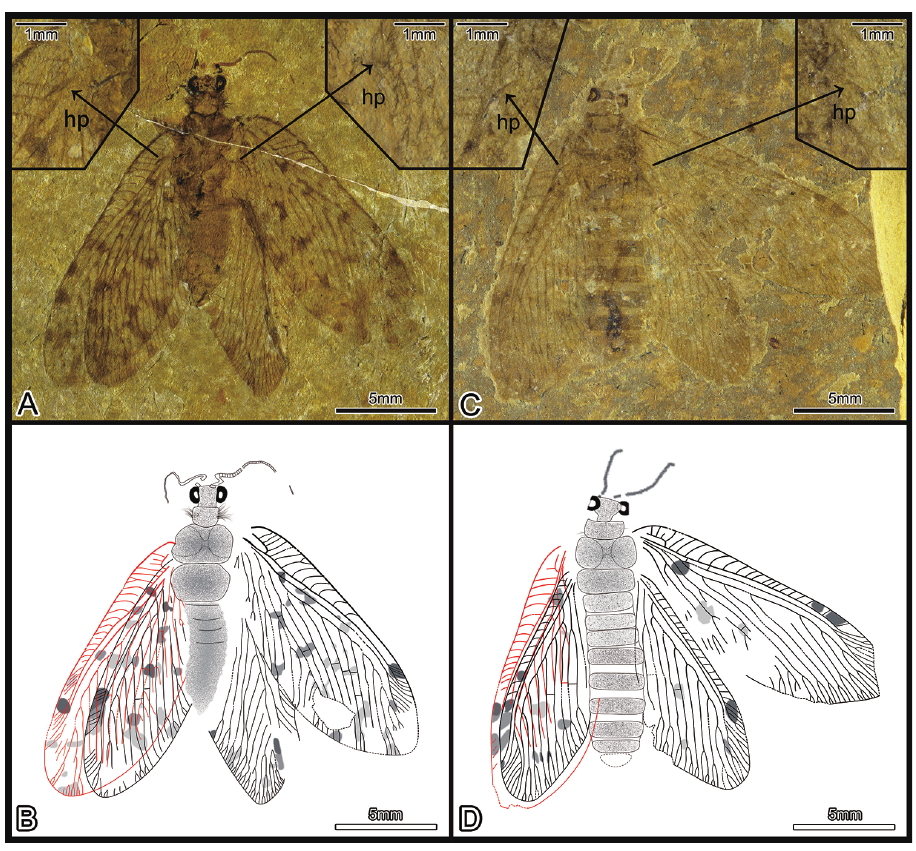
Figure 1. New materials of Lasiosmylus newi : CNU-NEU-LB2015001P/C, CNU-NEU-LB2015002. A composite photographs of habitus of part and counterpart (CNU-NEU-LB2015001P/C) hp, hu- meral plate (CNU-NEU-LB2015001C) B line drawing (CNU-NEU-LB2015001C) C habitus photo- graph, hp, humeral plate (CNU-NEU-LB2015002) D line drawing (CNU-NEU-LB2015002). Scale bars: 5 mm ( A–D